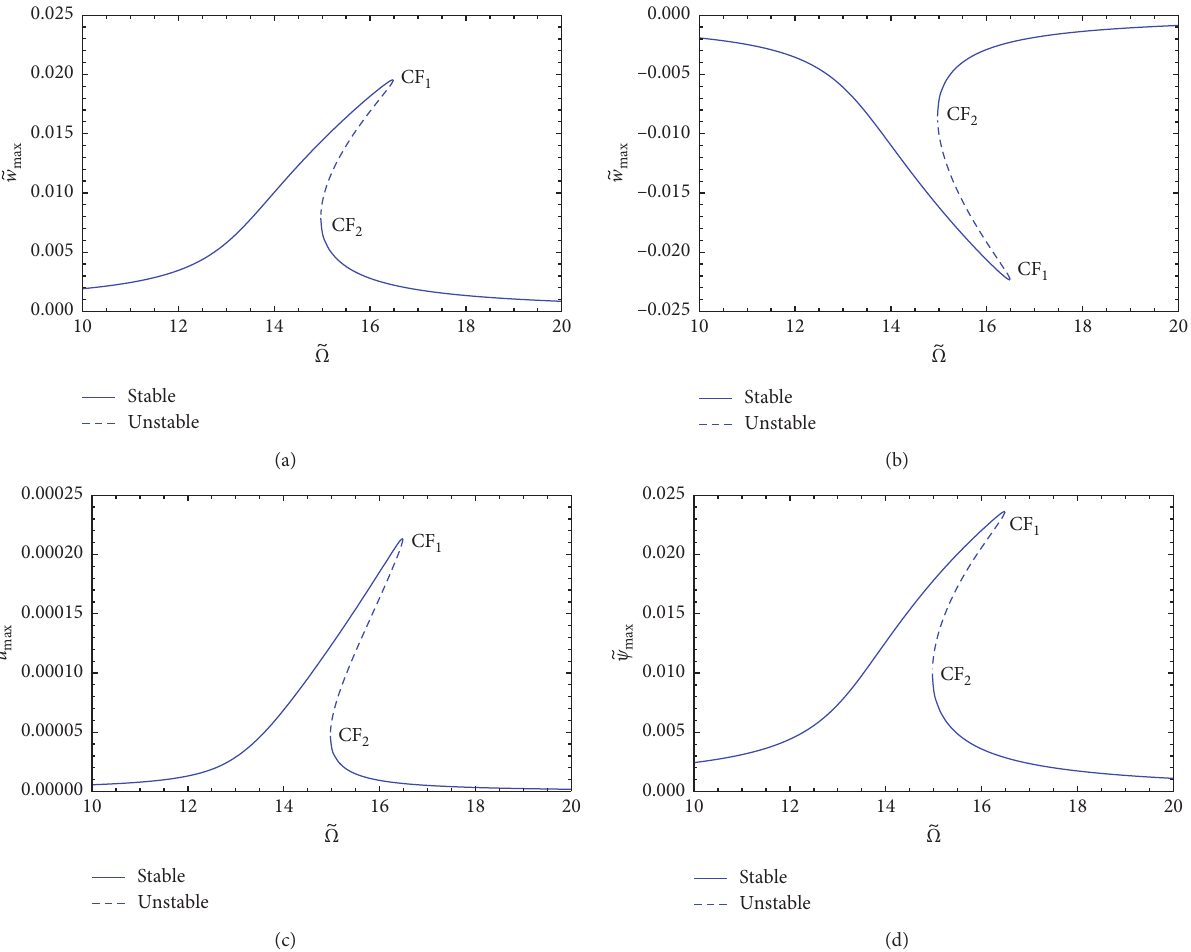
� m � 1, L / h � 20, 􏽥 c � 􏽥 c � 0 . 05, and 􏽥 f � 0 . 2. x z d r